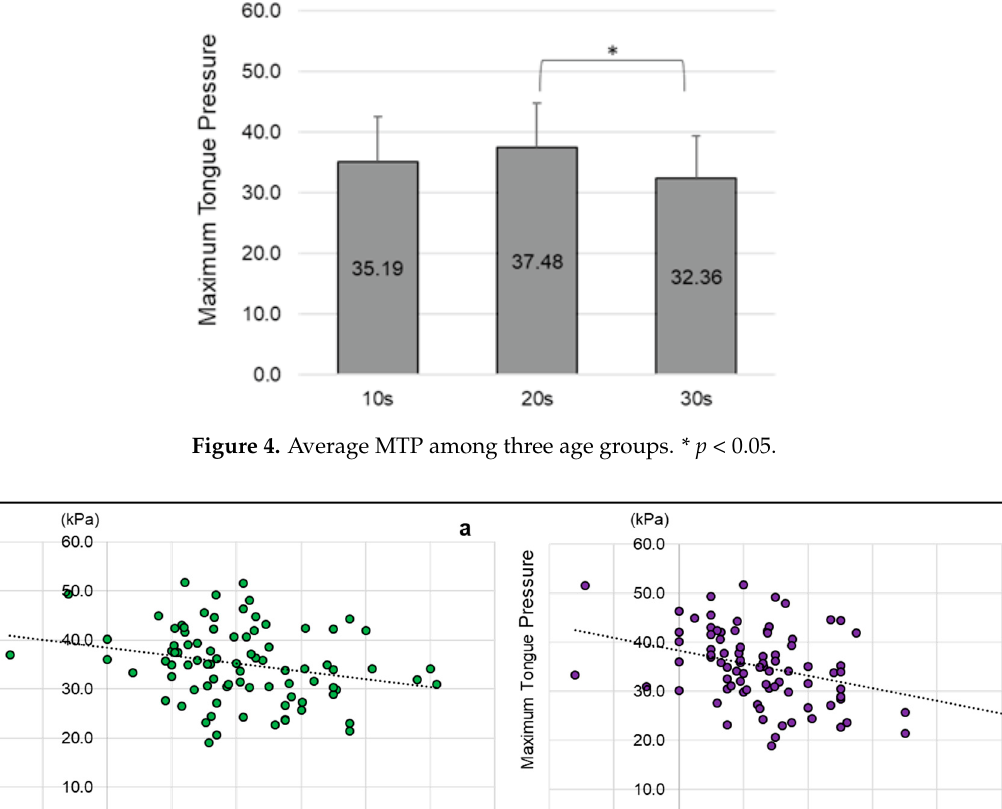
Figure 5. Correlation between MTP and overjet ( a ) and overbite (b ).